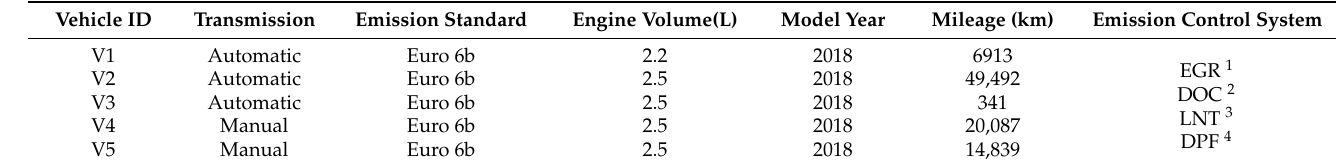
Table 1. Key specifications for test vehicles.